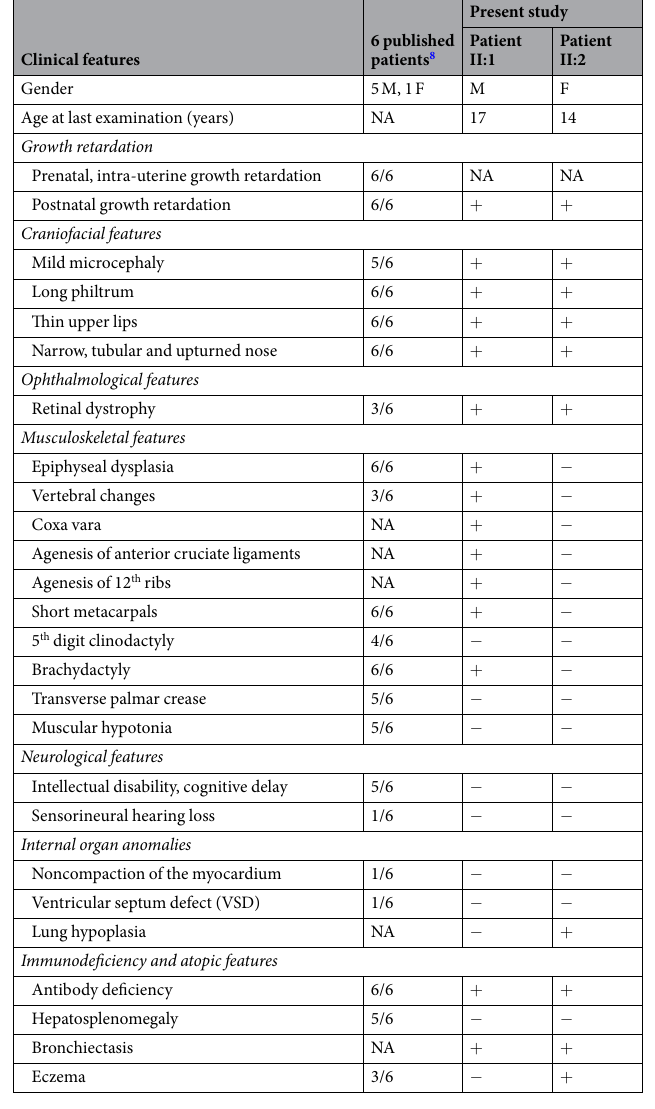
Table 4. Comparison of the family B patients with published cases of RNU4ATAC -associated Roifman syndrome. NA: not